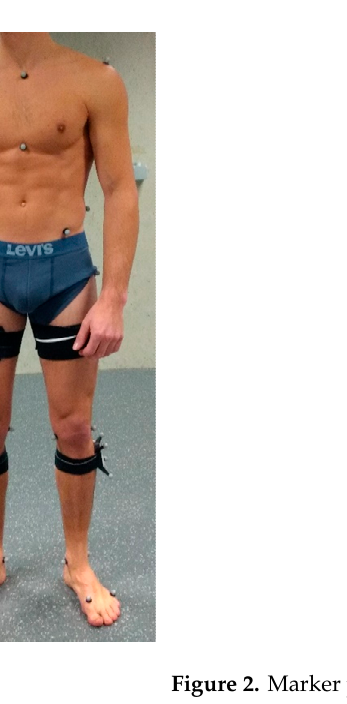
Figure 2. Marker placement.